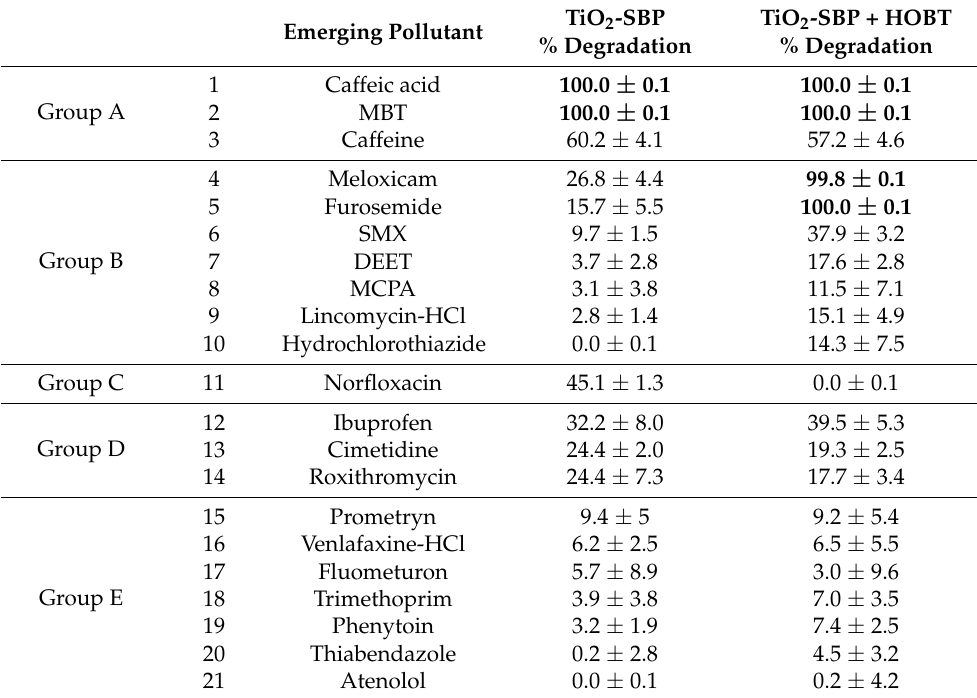
Table 2. Degradation of 21 Eps by TiO 2 -SBP ± HOBT.